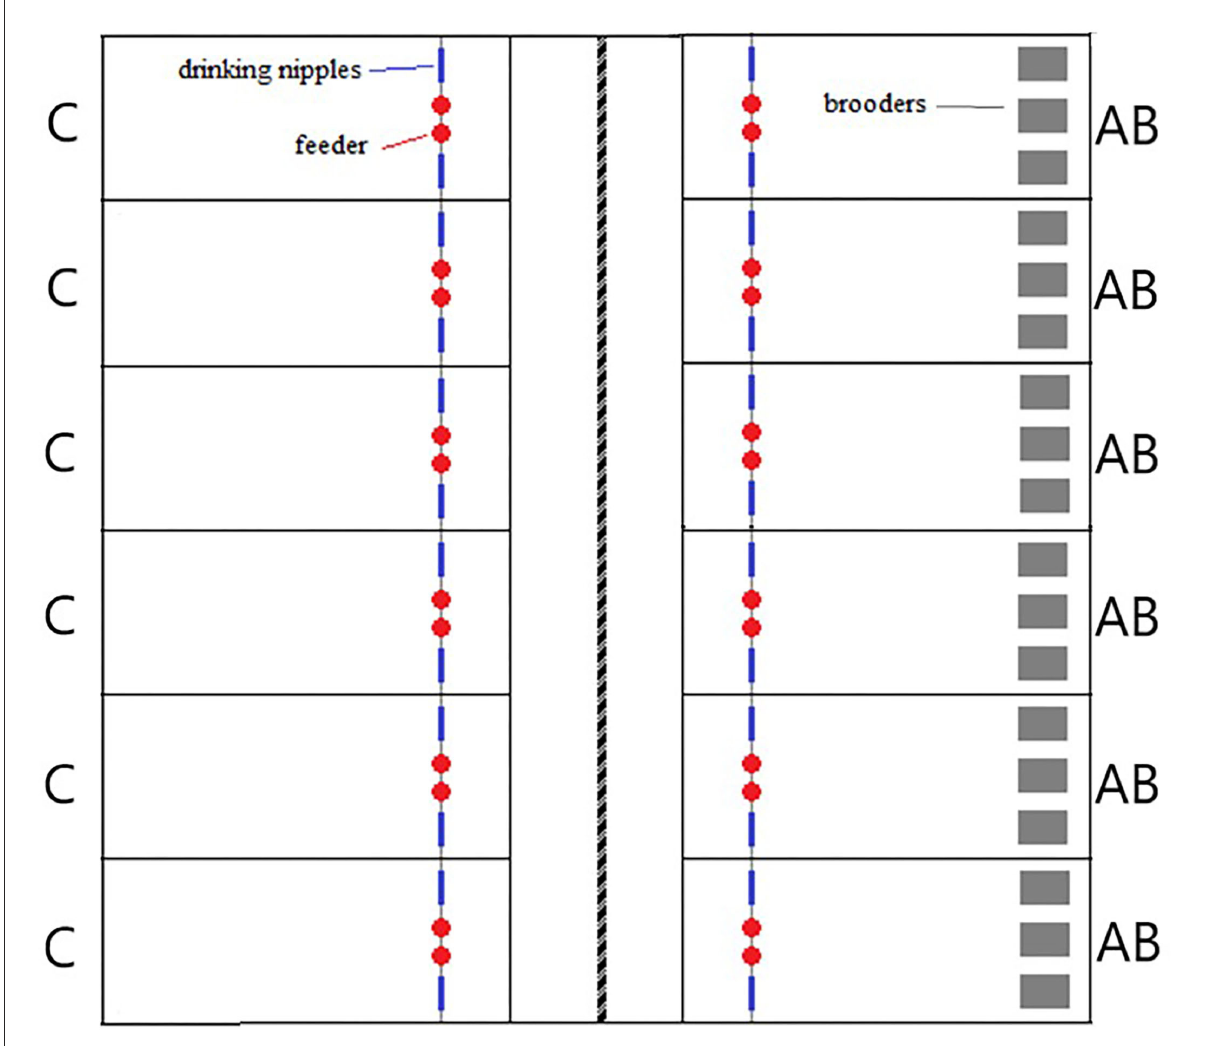
FIGURE1 Layout of the poultry barn housing the experimental pens. Pens marked C are the control groups and those marked AB are the groups with artificial brooders.